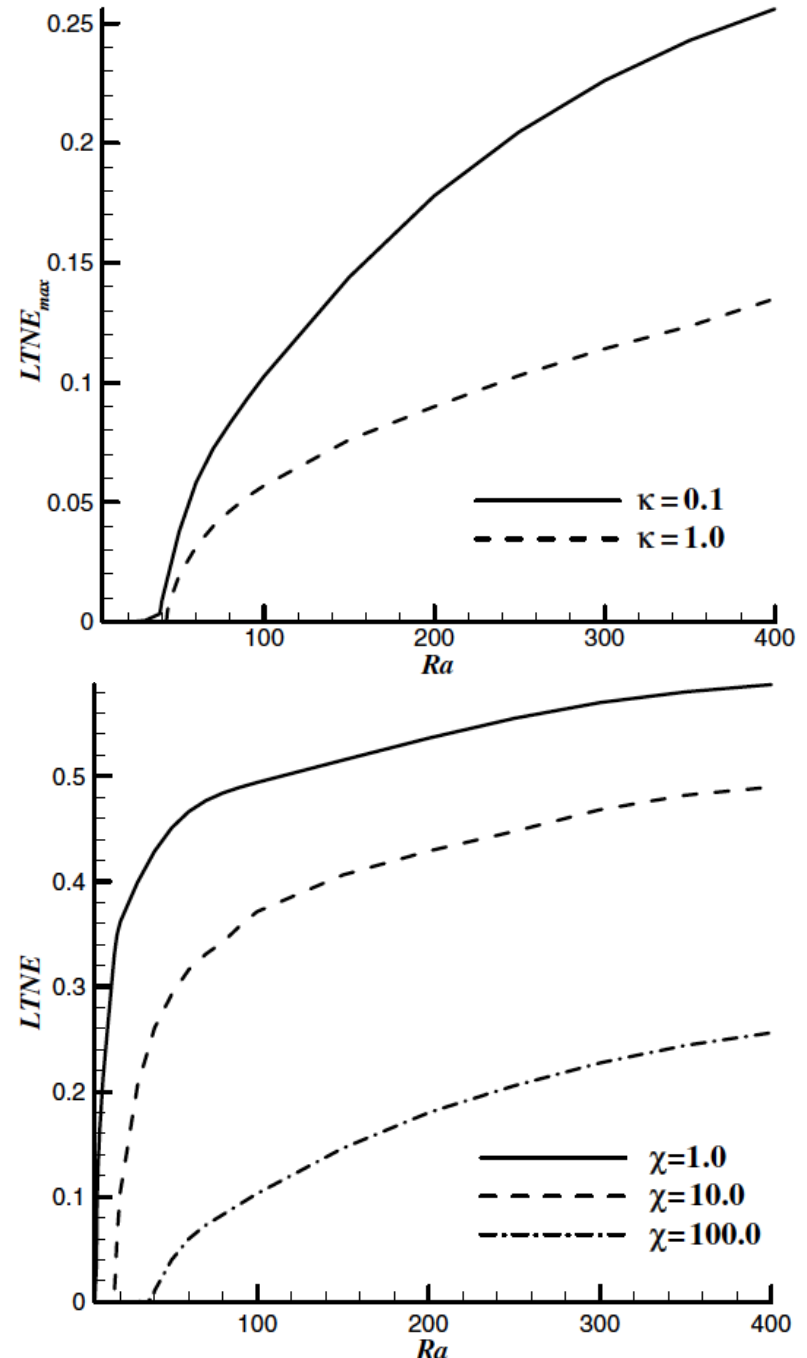
Figure 37. Influence of Rayleigh number on the LTNE for ( Top ) two fluid/solid thermal conductivity ratio ( k ) and ( Bottom ) three modified Biot numbers ( χ ), presented by Khashan et al.